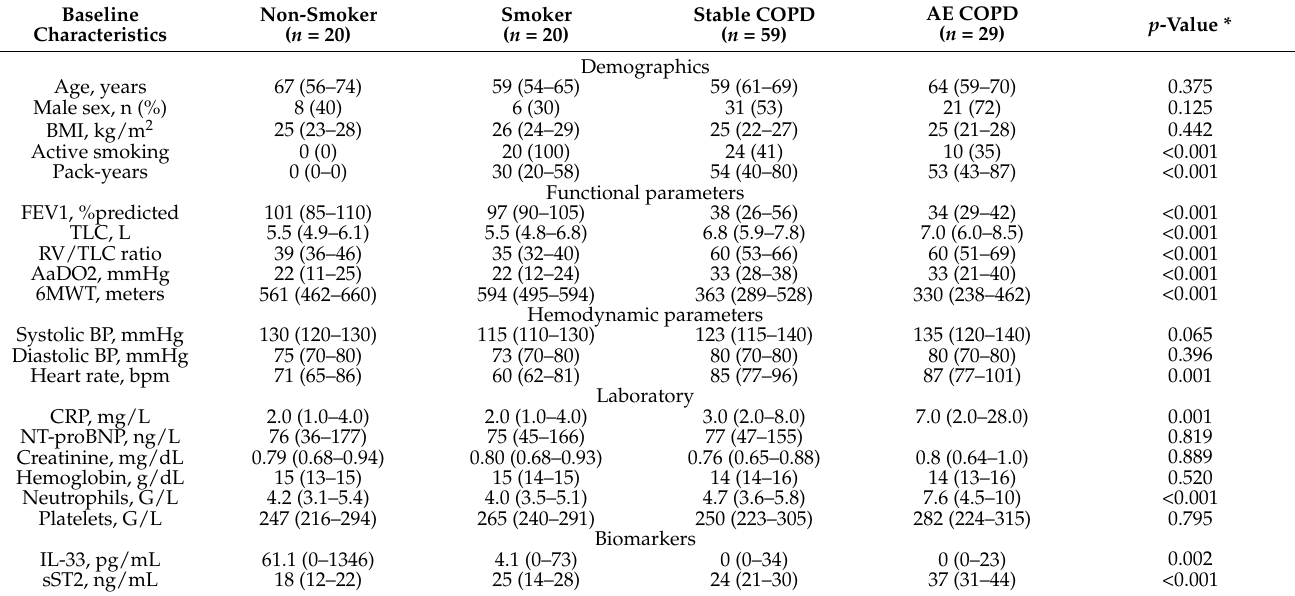
Table 1. Baseline clinical characteristics of the study